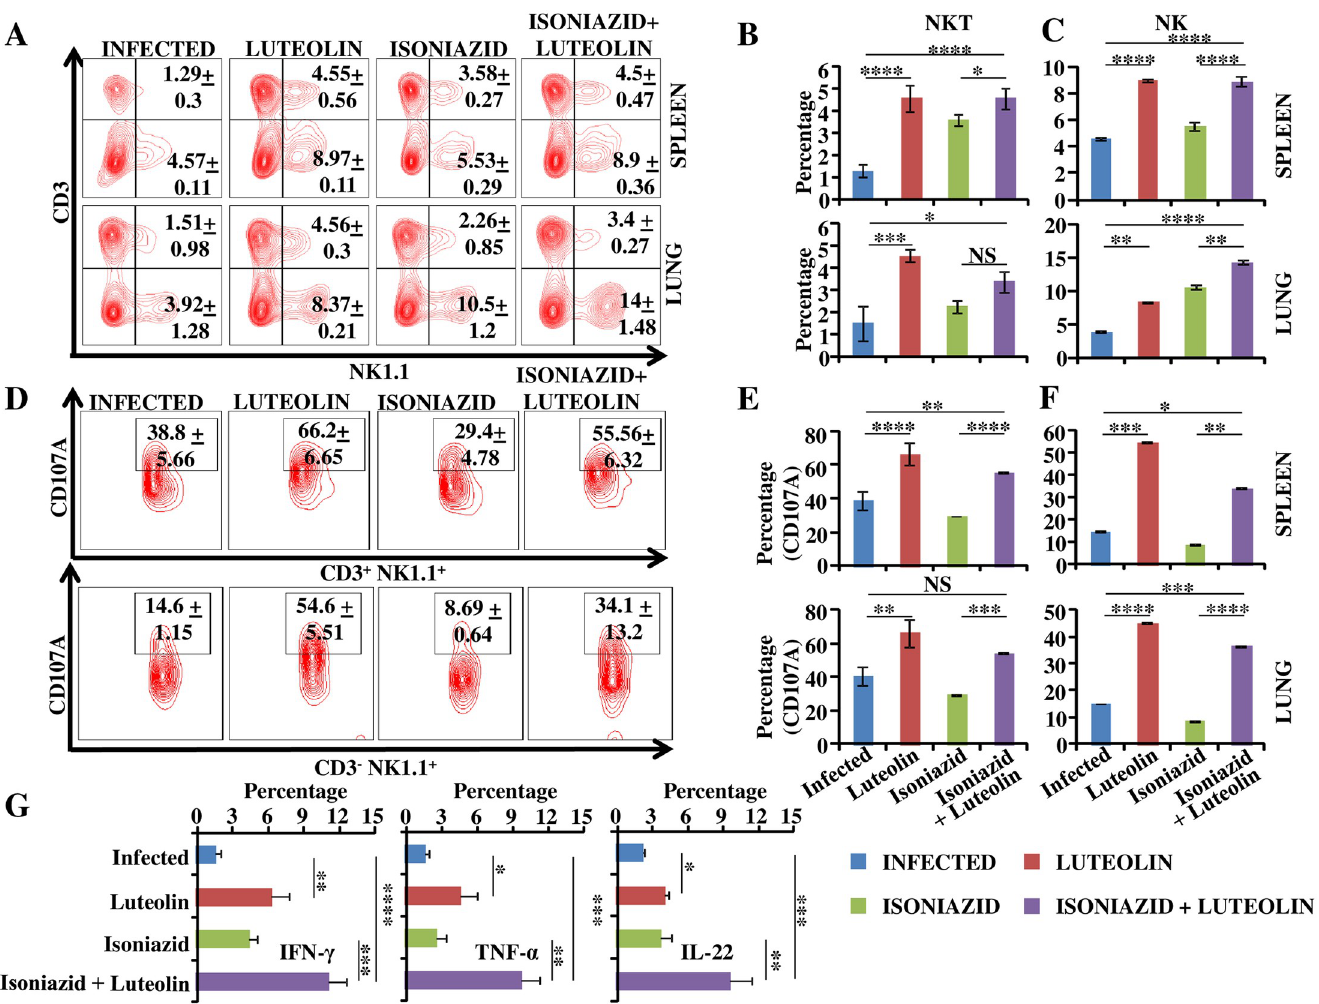
Fig 4. Luteolin-mediated anti-TB responses involve natural killer and natural killer T cells. Alveolar cells and splenocytes isolated from the indicated mice at 60 days post-infection were surface-stained with anti-CD3 and -NK1.1 antibodies. Representative FACS profile (A) and proportion of natural killer T (NKT) cells (B) and natural killer (NK) cells (C) in vivo in spleen (B&C, upper panel) and lung (B&C, lower panel) of different experimental groups. (D) Representative flow plots depicting antigen-specific degranulation potential of NKT (upper panel) and NK cells (lower panel) ex vivo . Fraction of degranulating NKT cells (E) and NK cells (F) in spleen (upper panel) and lung (lower panel). (G) Intracellular cytokine profiling of NKT cells in lungs. Data shown are representative of three independent experiments with three mice in each group and represent the MEAN ± STDEV values. Differences were considered significant at P < 0.05 and are represented by � p < 0.05, �� p < 0.01, ��� p < 0.001, ���� p < 0.0001 whereas non-significant differences are denoted by